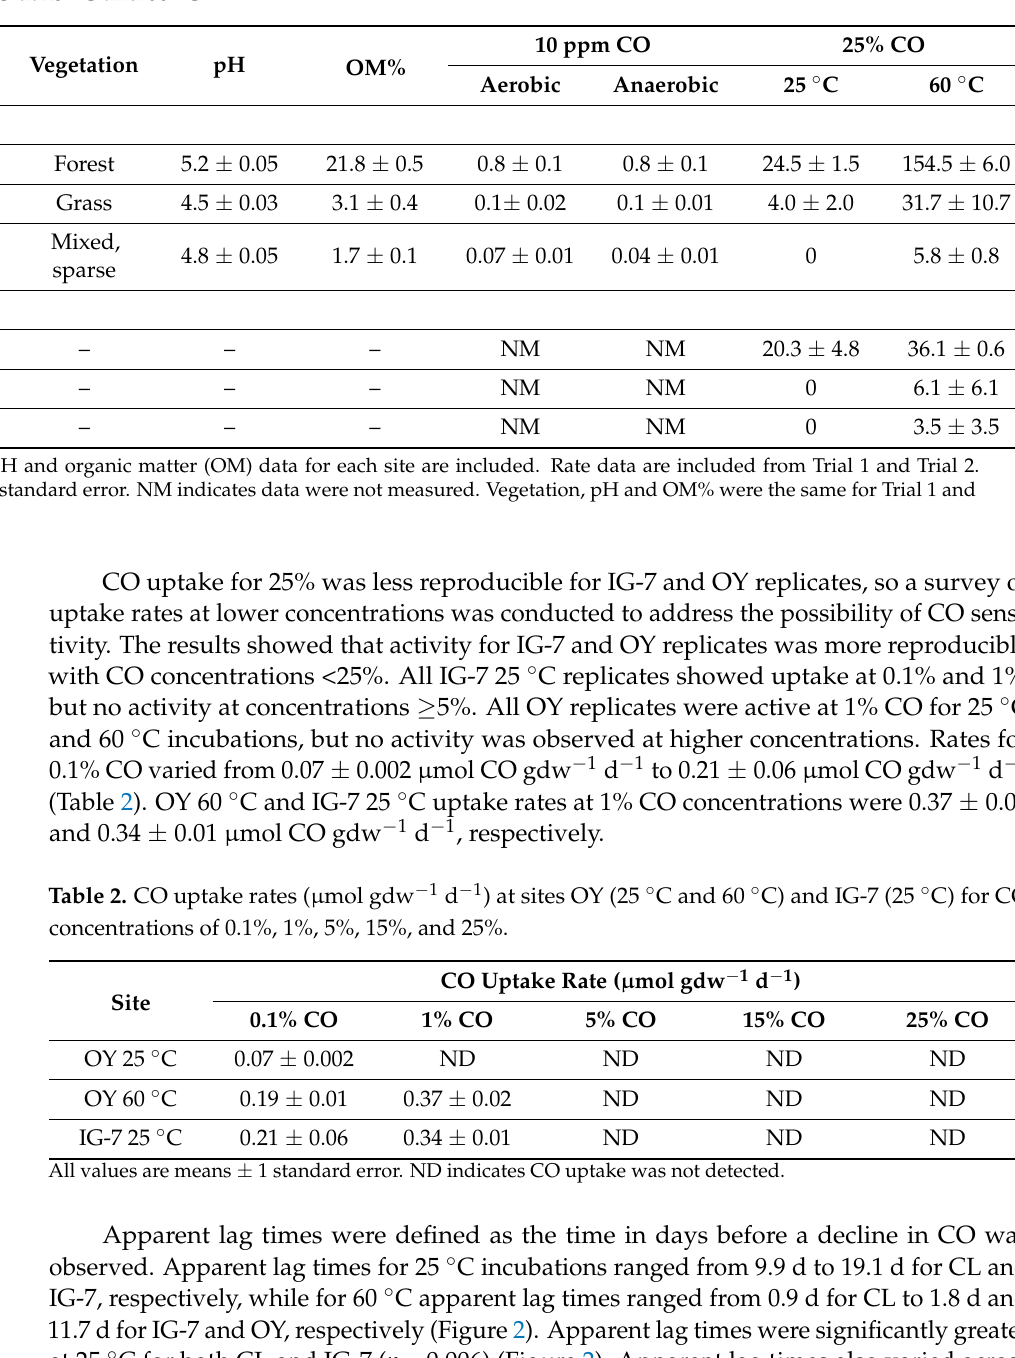
Table 1. Summary of CO uptake rates ( µ mol gdw − 1 d − 1 ) at CL, IG-7, and OY for 10 ppm CO under aerobic and anaerobic conditions, and 25% CO at 25 ◦ C and 60 ◦ C.